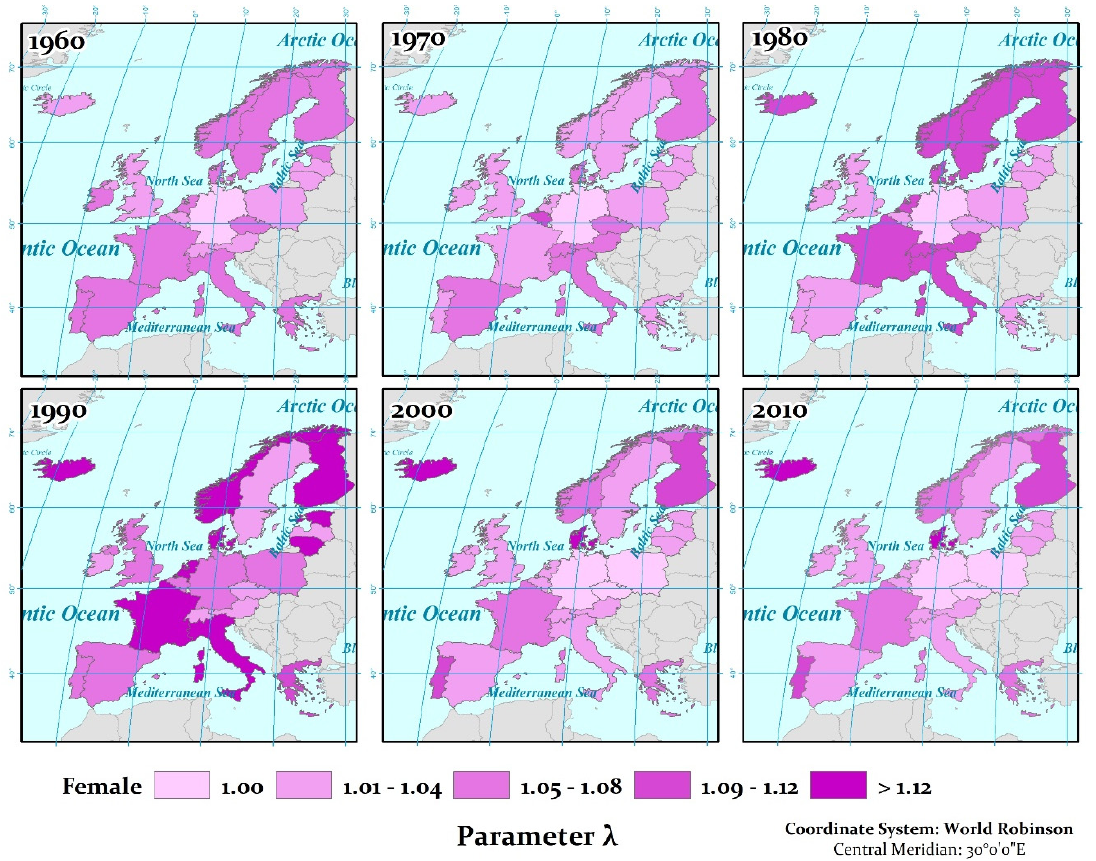
Figure 3. The evolution of random risk factor for the 22 EU countries (parameter λ —female). Moving on to the next chronological phase from 2010 to 2040 (Figures 1, 4 and 5), the change of the parameter λ shows signs of stabilization. Values of parameter λ for men and women are very close, while after 2040, the model forecasts a new opening of the "gap" trend for men (Figure 4), respectively.